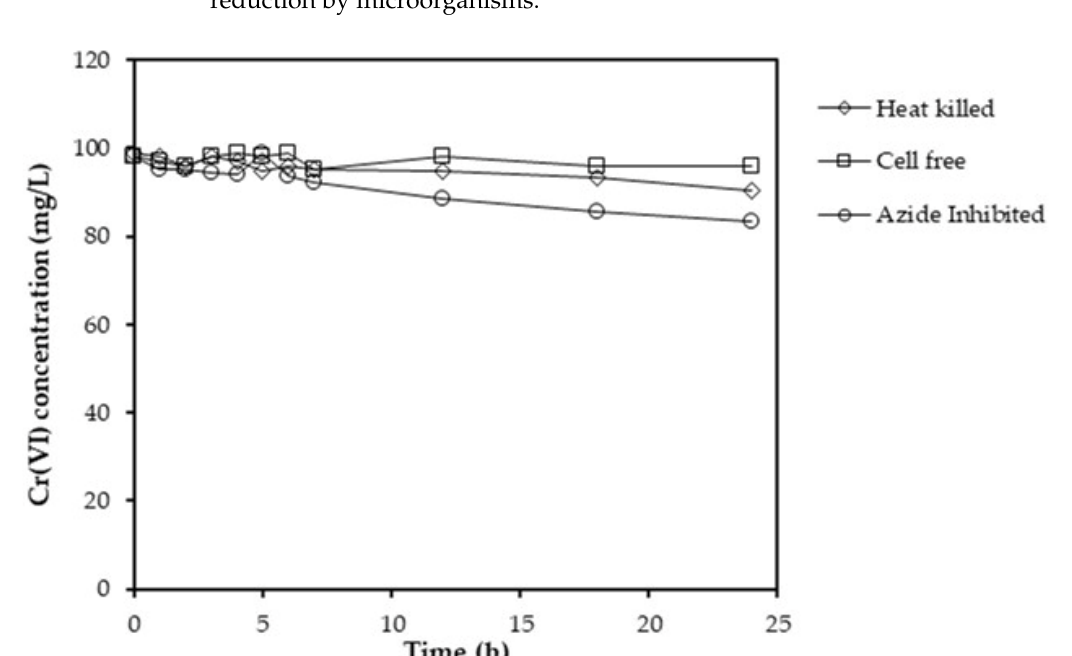
Figure 1. Evaluation of abiotic reduction of Cr(VI) by heat-killed and azide inhibited reducing cells under aerobic conditions.